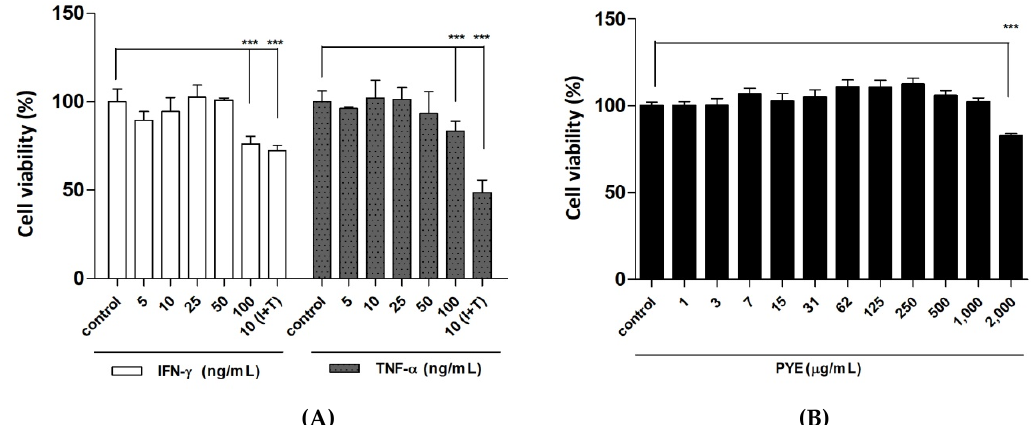
Figure 1. Cell viability at various treatment concentrations of interferon (IFN)-γ, tumor necrosis factor (TNF)-α, and Pyropia yezoensis extract (PYE) on HaCaT cells. Cells were incubated with the indicated concentration of each cytokine (IFN-γ (I) and TNF-α (T)), alone or (I+T) combined for 24 h (A) . HaCaT cells were treated with various treatment concentrations of PYE for 24 h (B) . Cell viability was then determined by the 3-(4,5-dimethylthiazol-2yl)-2,5-diphenyl-2H-tetrazolium bromide (MTT) assay. Results are expressed as means ± standard deviation (SD) of triplicate experiments. Statistical comparisons of different treatments were performed using one-way analysis of variance (ANOVA) with Tukey’s multiple comparison test. Note: *** p < 0.001 compared with the control group.